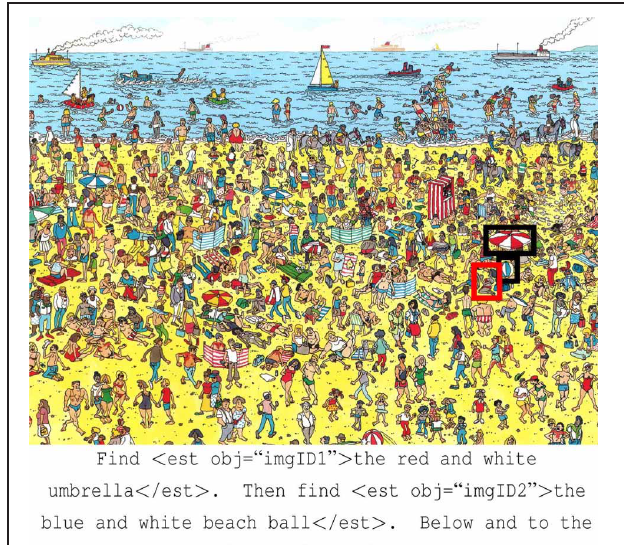
FIGURE 4 | Example hard stimulus (target in red box) and annotated referring expression. Two landmarks (the umbrella and ball) are introduced with the word “find” and marked with < est > tags; the ball is then used to localize the target. Black boxes added by the